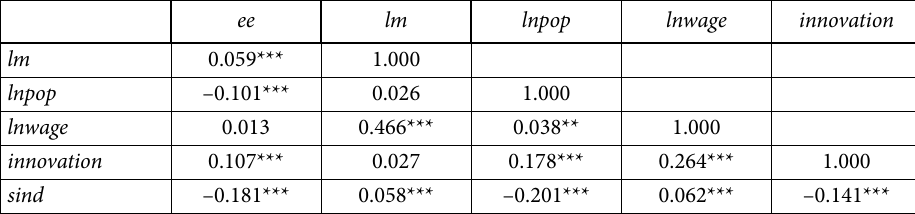
Table 2. Correlation among dependent